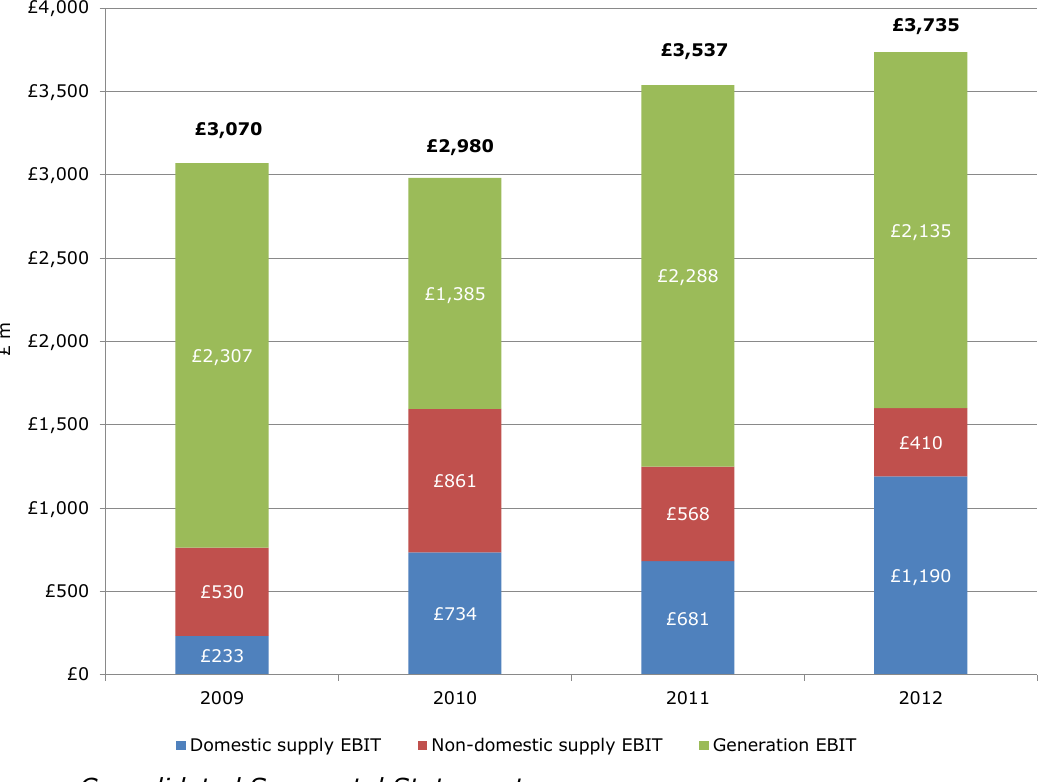
Figure 2: Earnings before Interest and Tax (EBIT) of the six largest suppliers